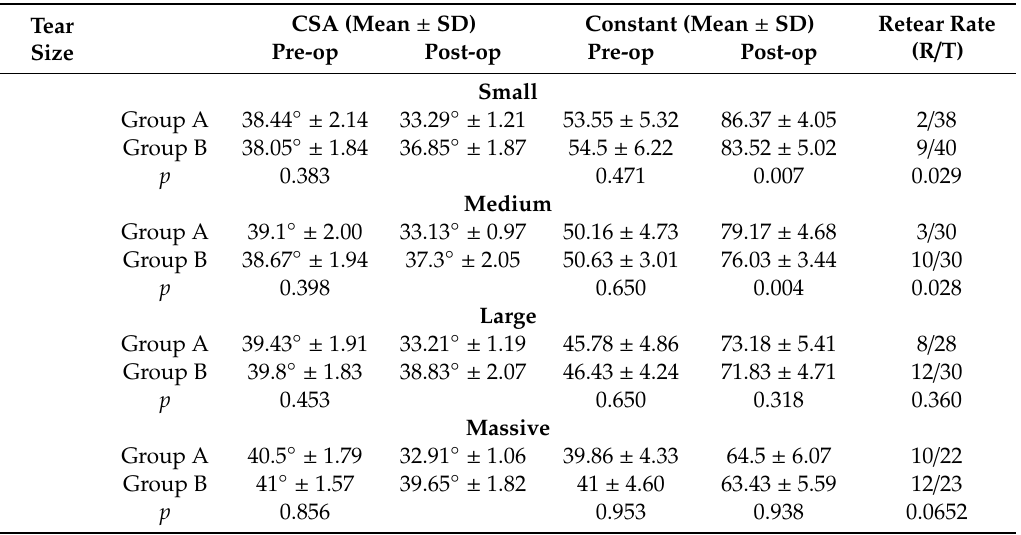
Table2. ComparisonoftheinfluenceofLateralAcromioplastyonConstant–MurleyScorepreoperatively and postoperatively and retear rate in 4 subgroups of patients, characterized by the tear size. CSA (Mean ± Tear Size